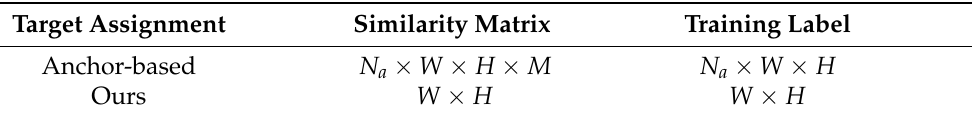
Table 1. Tensor size comparison of our method with the anchor-based algorithms in terms of target assignment. We generated classification labels directly from the ground truth bounding boxes, which completely avoided the complicated IoU calculations using the anchor boxes and the ground truth bounding boxes. H × W denotes the heatmap size, N a is the number of anchors per location and M is the number of ground truth 3D boxes in a LiDAR point